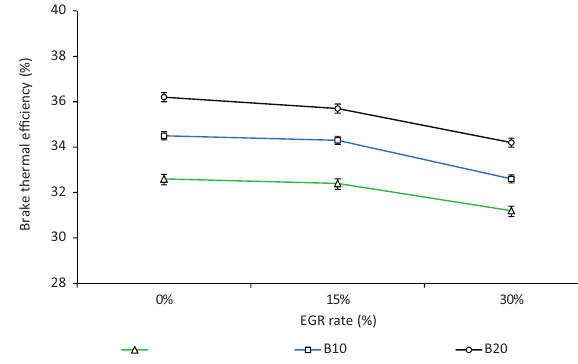
Figure 2. Effect of alcohol blends and EGR rates on the variation of cylinder pressure